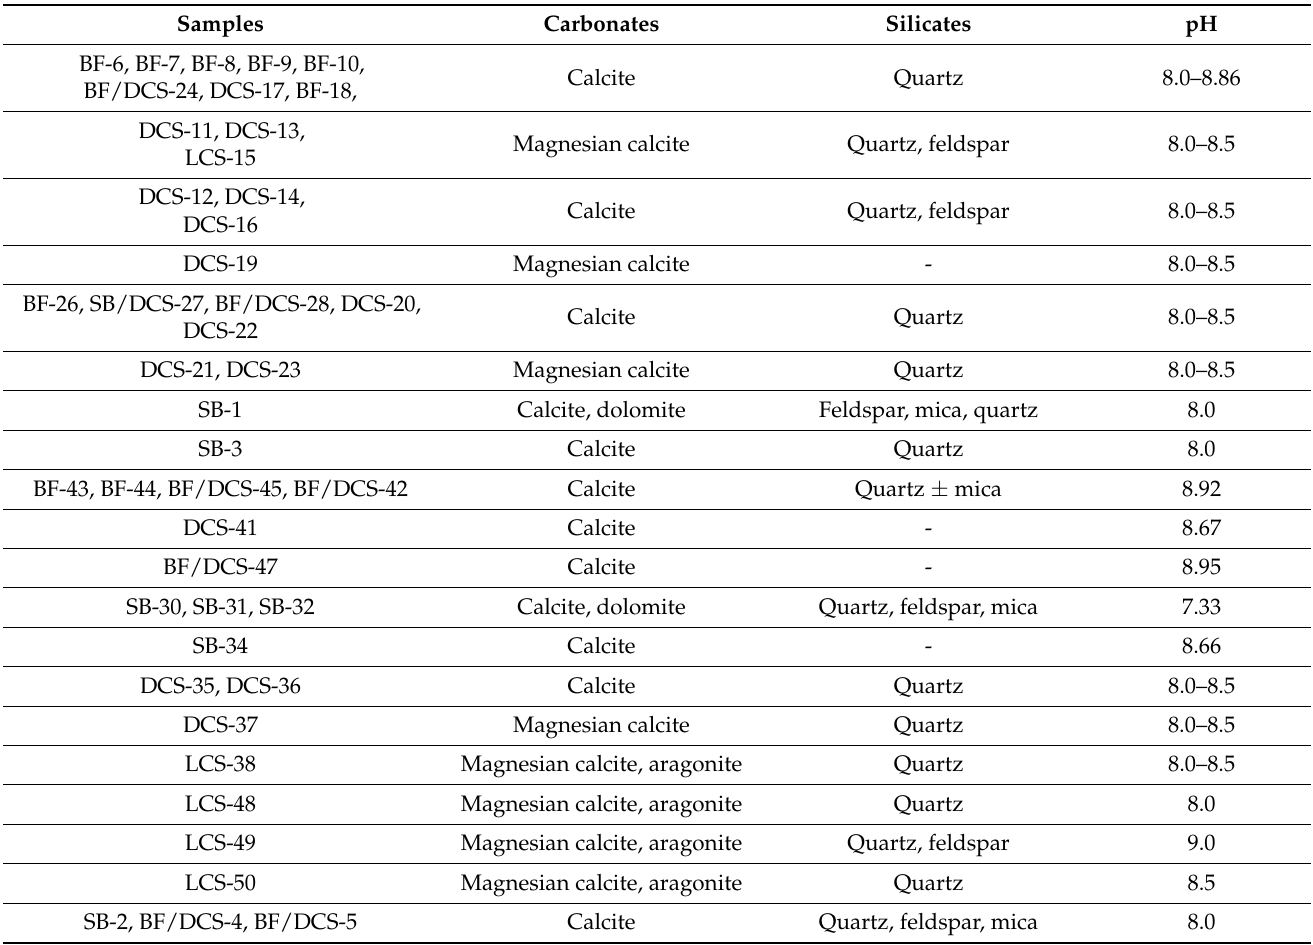
Table 2. Mineral composition of water deposits and pH of